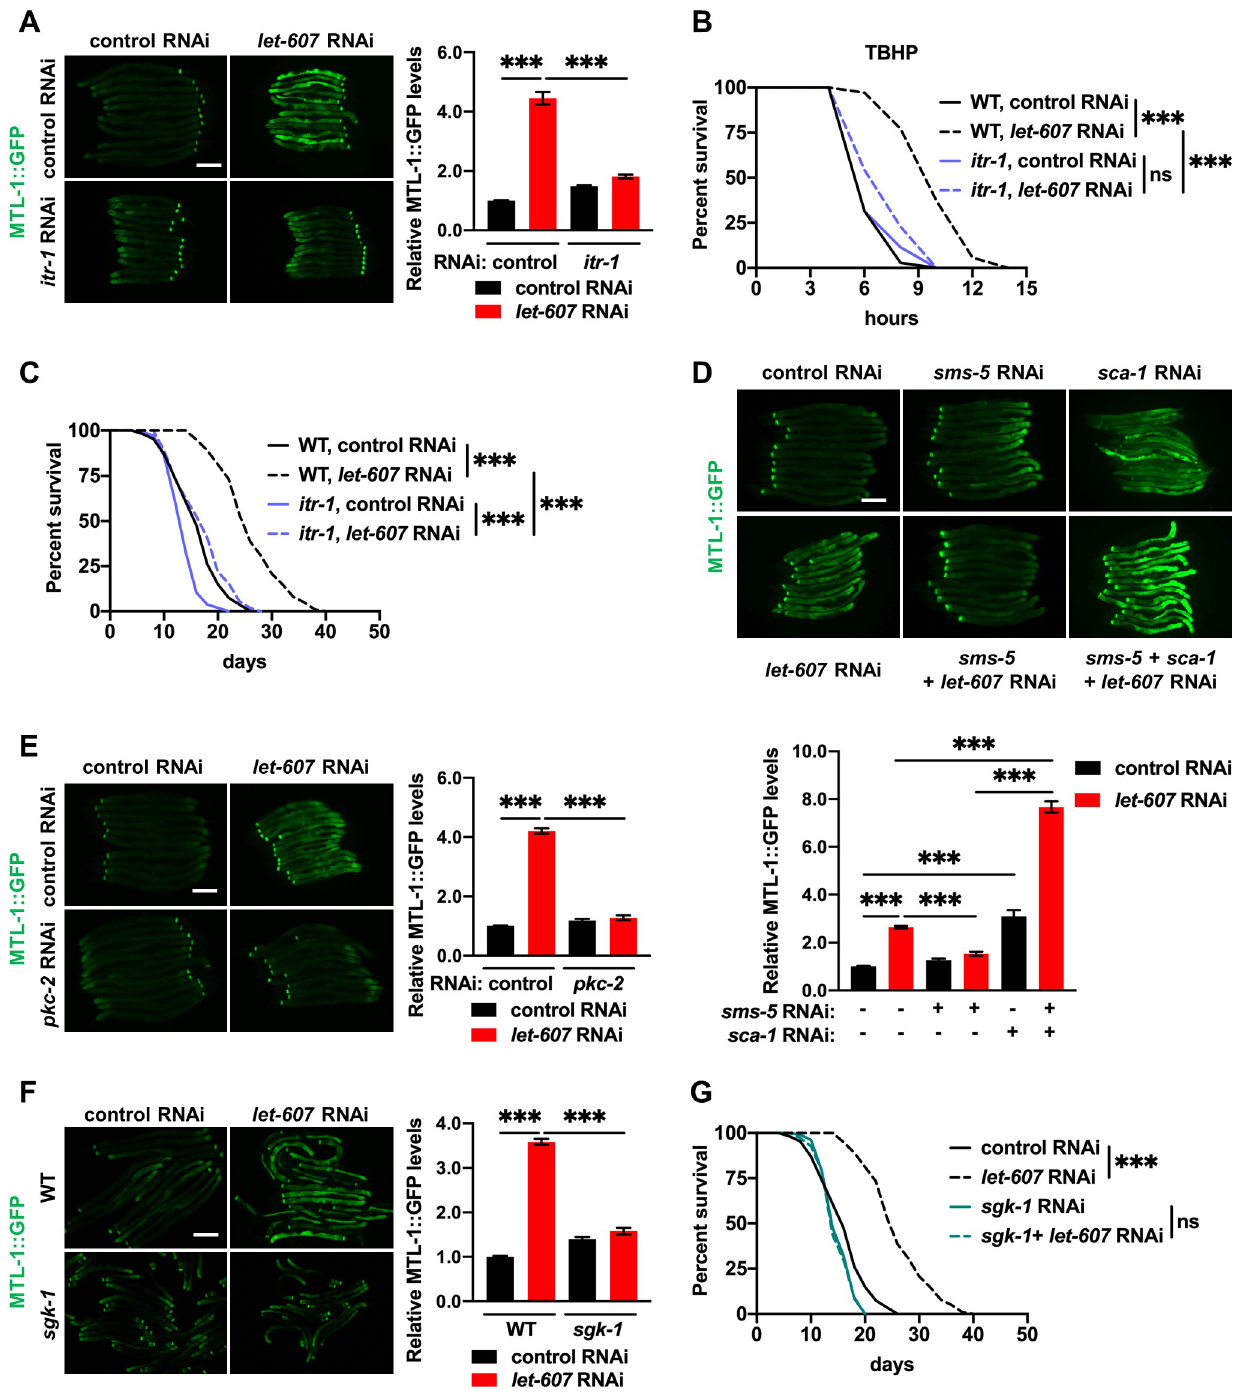
Fig 7. Crosstalk between LET-607 and DAF-16 depends on calcium signaling and calcium-sensitive kinase. (A) Effects of itr-1 RNAi on let-607 knockdown-induced MTL-1::GFP expression. Left panel, representative images. Right panel: quantification data. Scale bar = 100 μ m. (B-C) Effects of itr-1 mutation on let-607 RNAi-induced TBHP resistance (B) and longevity (C) in C . elegans . (D) Effects of sca -1 RNAi on the expression of MTL-1::GFP which is suppressed by sms-5 RNAi. Upper panel, representative images. Lower panel: quantification data. Scale bar = 100 μ m. (E-F) Effects of pkc-2 RNAi (E) and sgk-1 mutation (F) on let-607 knockdown-induced MTL-1::GFP expression. Left panel, representative images. Right panel: quantification data. Scale bar = 100 μ m. (G) Influence of sgk-1 RNAi on the lifespan of WT and let-607 knockdown worms. Data were presented as mean ± SEM. ��� p < 0.001.